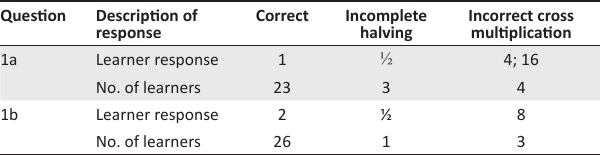
TABLE 1: Learner responses to Question 1a and Question 1b ( N = 30). Question Description of response